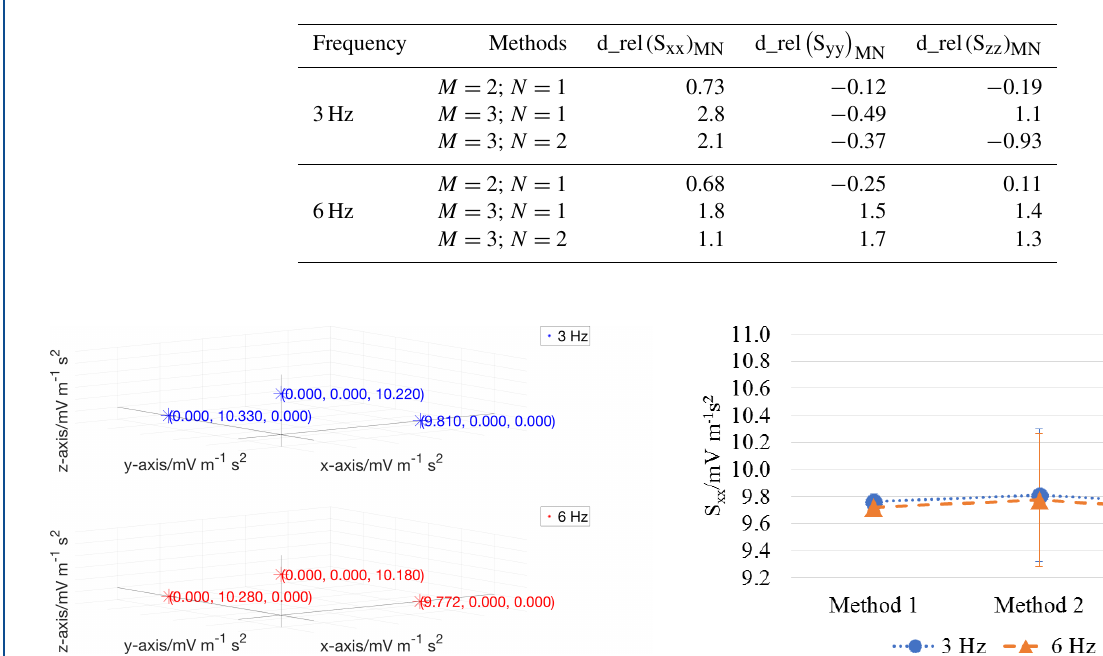
Table 4. MEMS accelerometer: comparison between methods (%).